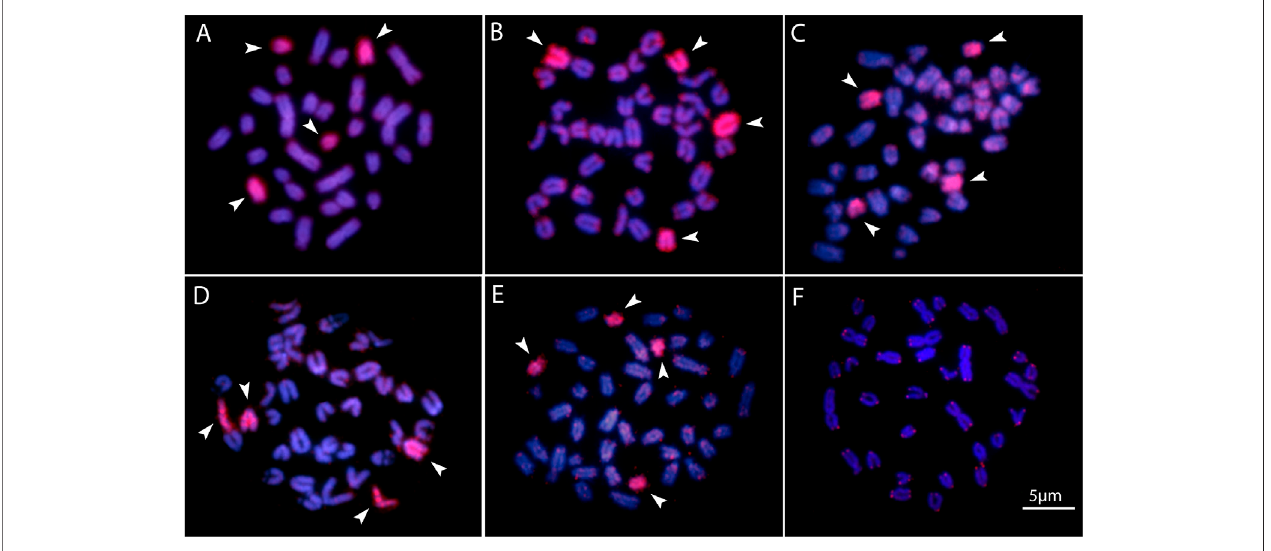
FIGURE4| Zoo-FISHwiththePSEMI-Yprobeonmalemetaphaseplatesof P.marilynae (A) , Pyrrhulina aff. marilynae (B) , Pyrrhulina cf. laeta (C) , Pyrrhulina sp. (D) , and P. obermulleri (F) shows the distribution of the telomeric (TTAGGG)n repeats in P. marilynae . Bar (cid:1) 5 μ m.